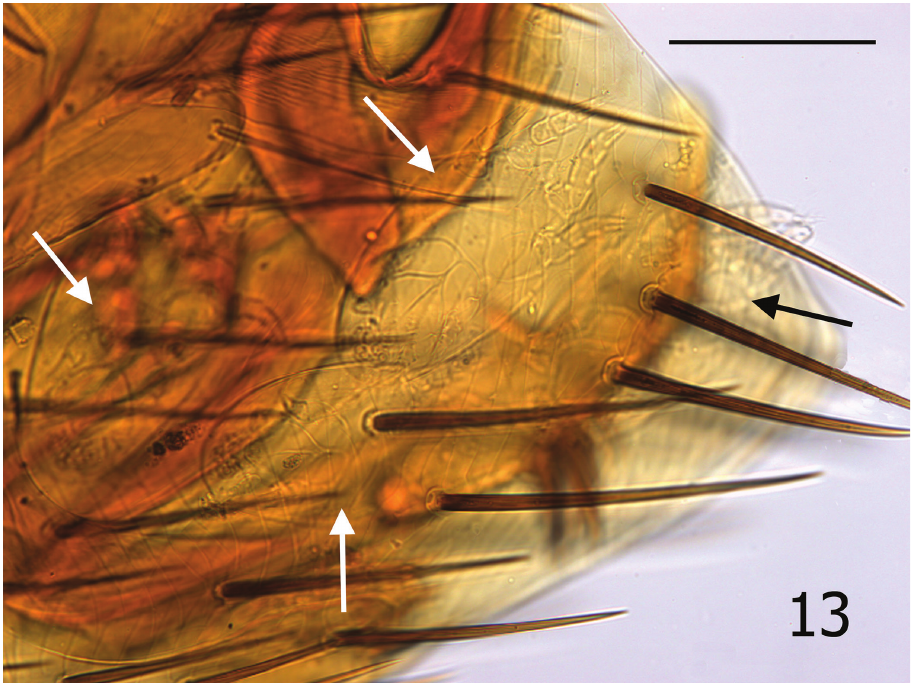
Figure 13. Medwayella independencia , sp. n., holotype male (P-5525) terminal segments illustrating four mites beneath T-VIII (see arrows). (Scale: 400